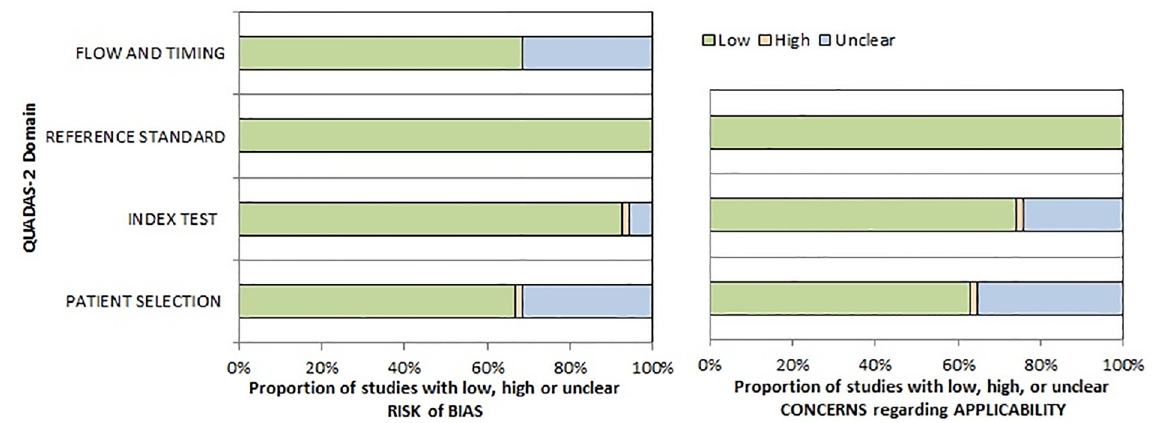
Fig 2. QUADAS-2 quality assessment of the included studies. There were no possible concerns of the references standard. A small amount of studies showed unclear bias regarding flow and timing, patient selection and index test.